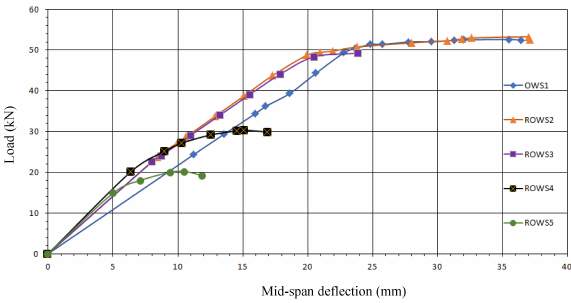
Figure 11: Load-deflection curve for all